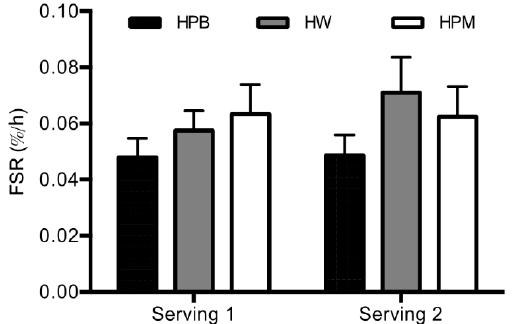
Figure 3. Mean ± SEM 2.5 h FSR after serving 1 and serving 2, n = 18. Differences in FSR between